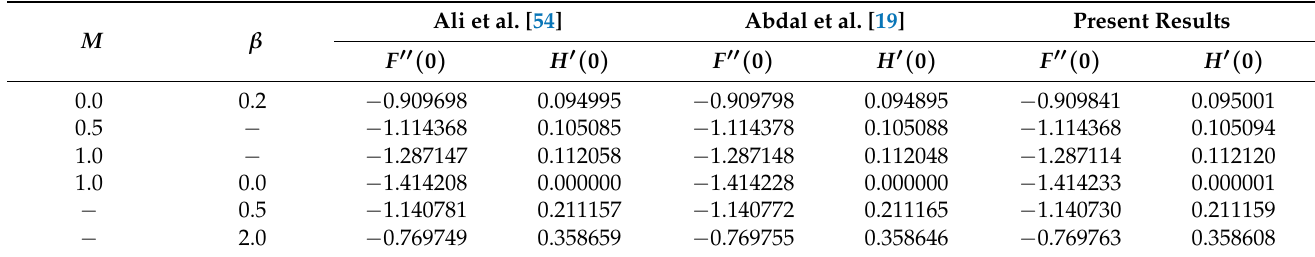
Table 3. F (cid:48)(cid:48) ( 0 ) and H (cid:48) ( 0 ) against M and β when λ = Ω = γ = (cid:101) = Φ = 0.0, χ 1 = 1.0.